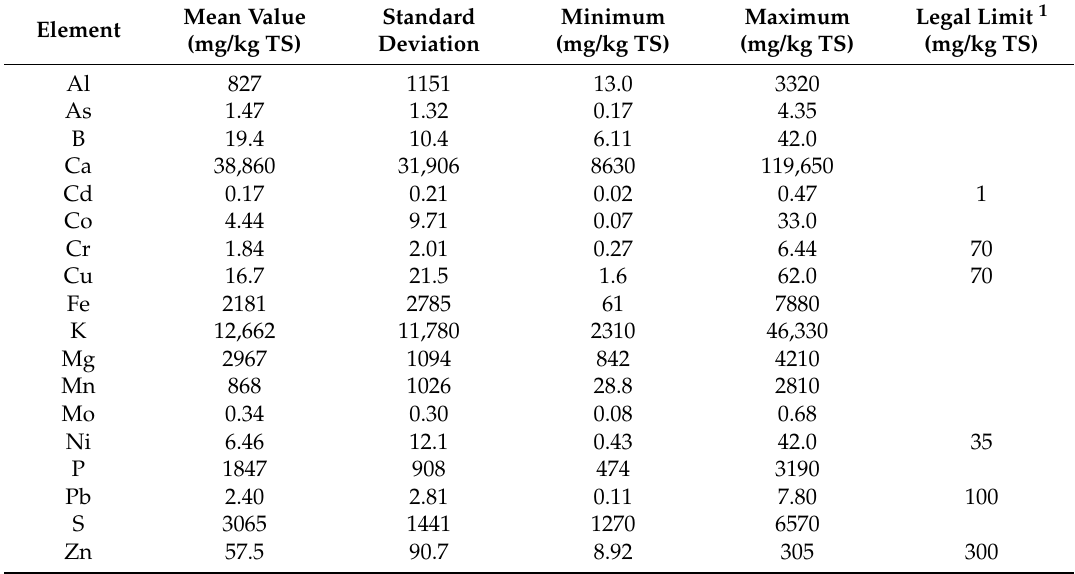
Table 6. Concentrations of elements in plant material in samples from standing bodies of water.